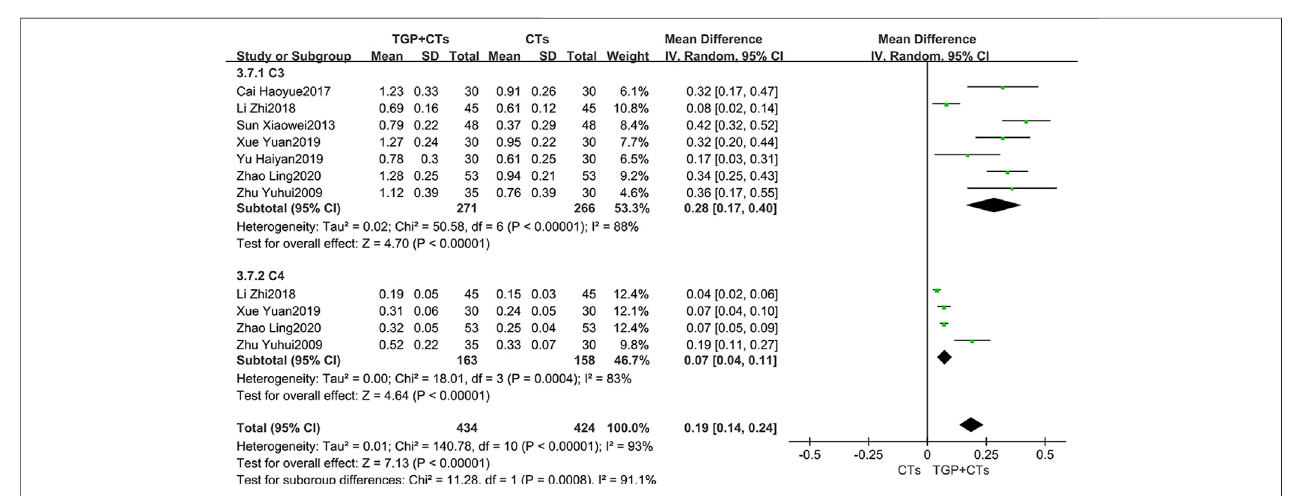
FIGURE 6 | Forest plot of C3 and